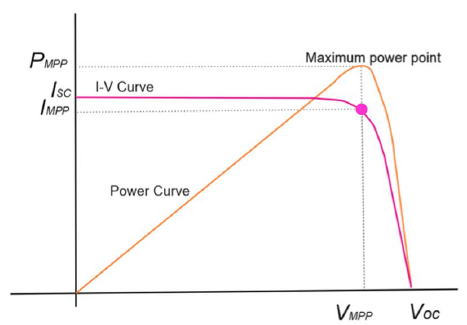
Figure 2. Maximum power point curve.